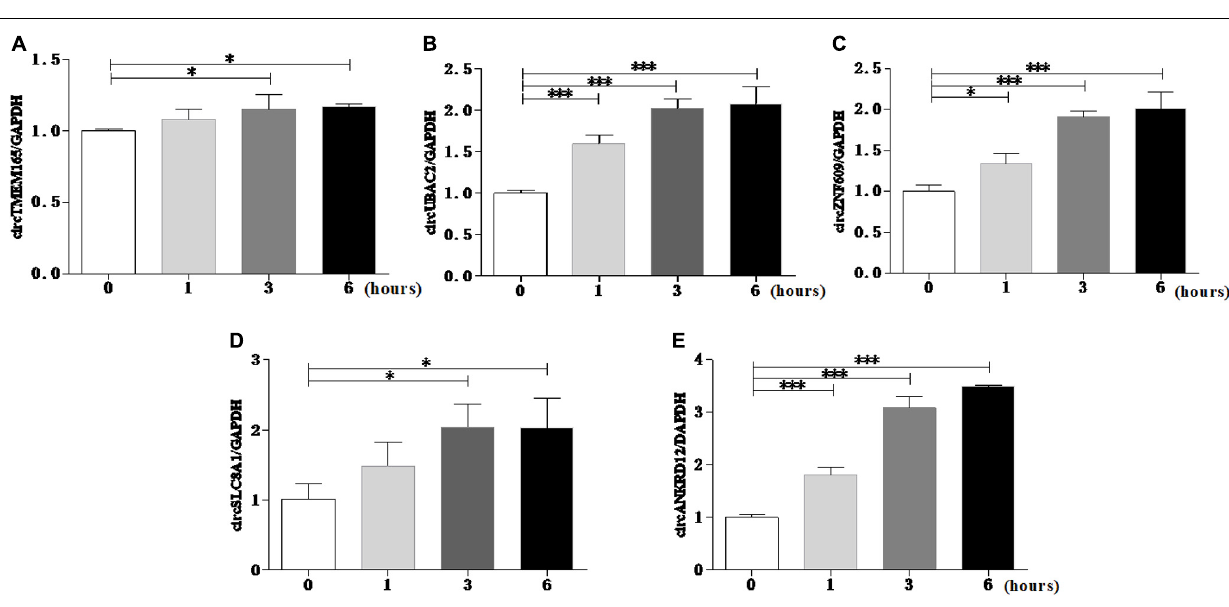
Frontiers in Cardiovascular Medicine |